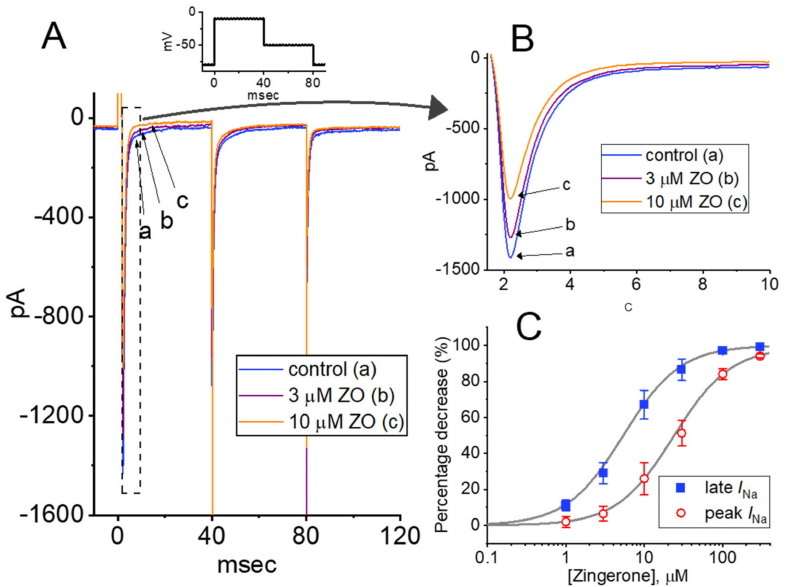
Figure 1. Effect of zingerone (ZO) on voltage-gated Na + current ( I Na ) recorded from pituitary